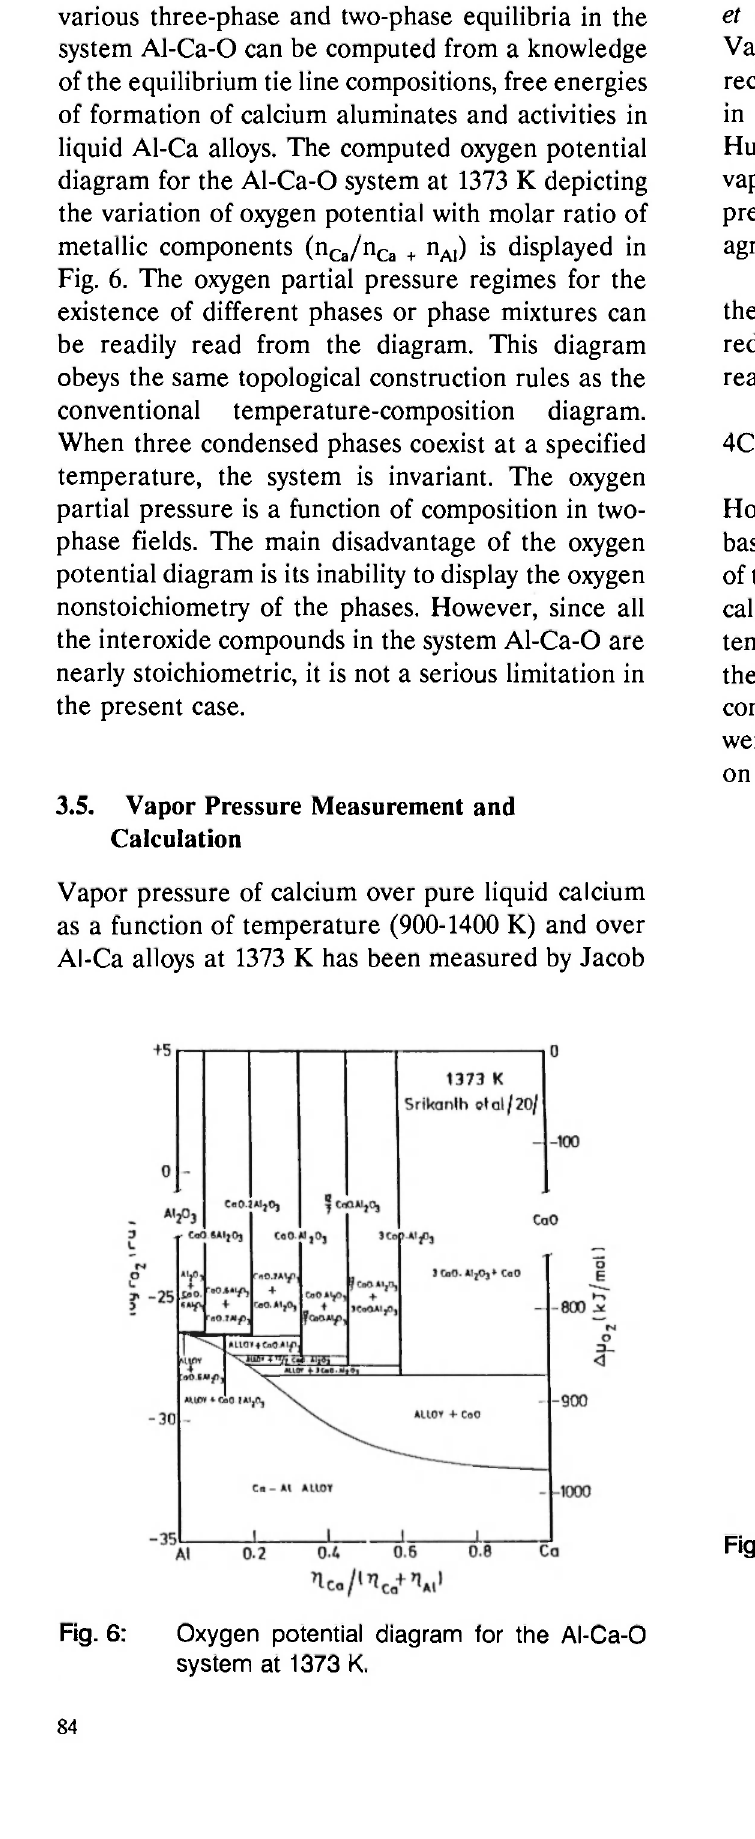
Fig. 6: Oxygen potential diagram for the Al-Ca-O system at 1373 K.